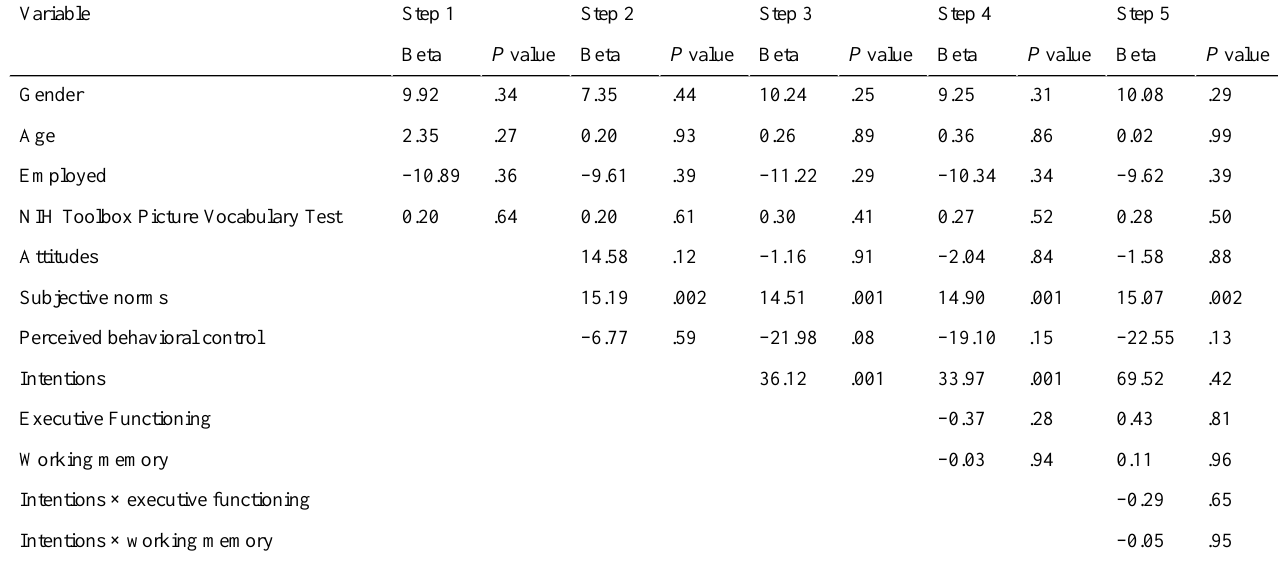
Table 5. Hierarchical regression analyses: Theory of Planned Behavior constructs and executive function as predictors of number of minutes using a mindfulness meditation phone app